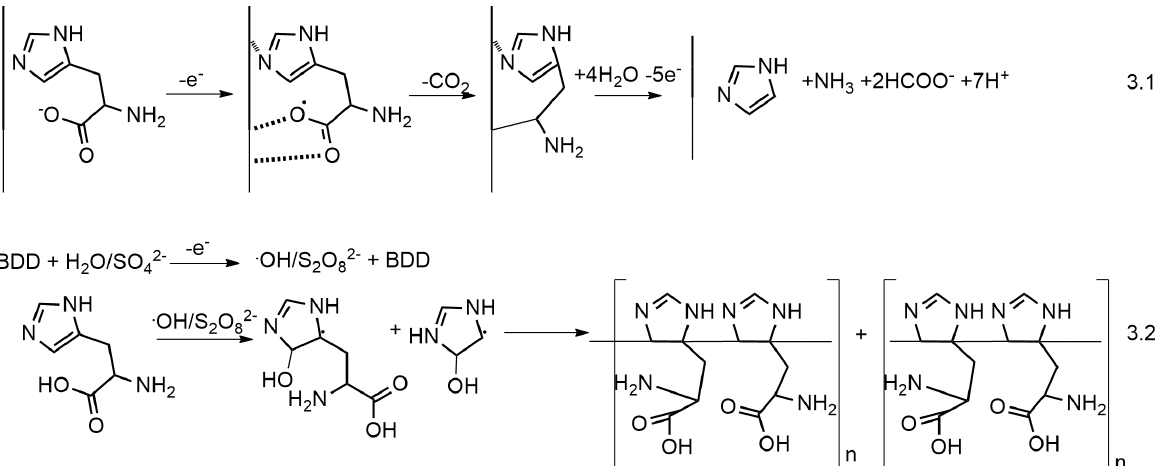
Figure 4 - Oxidation pathways proposed for L-His oxidation onto metallic electrodes by 3.1 (Ogura et al. 1999) and 3.2 (Chen et al.